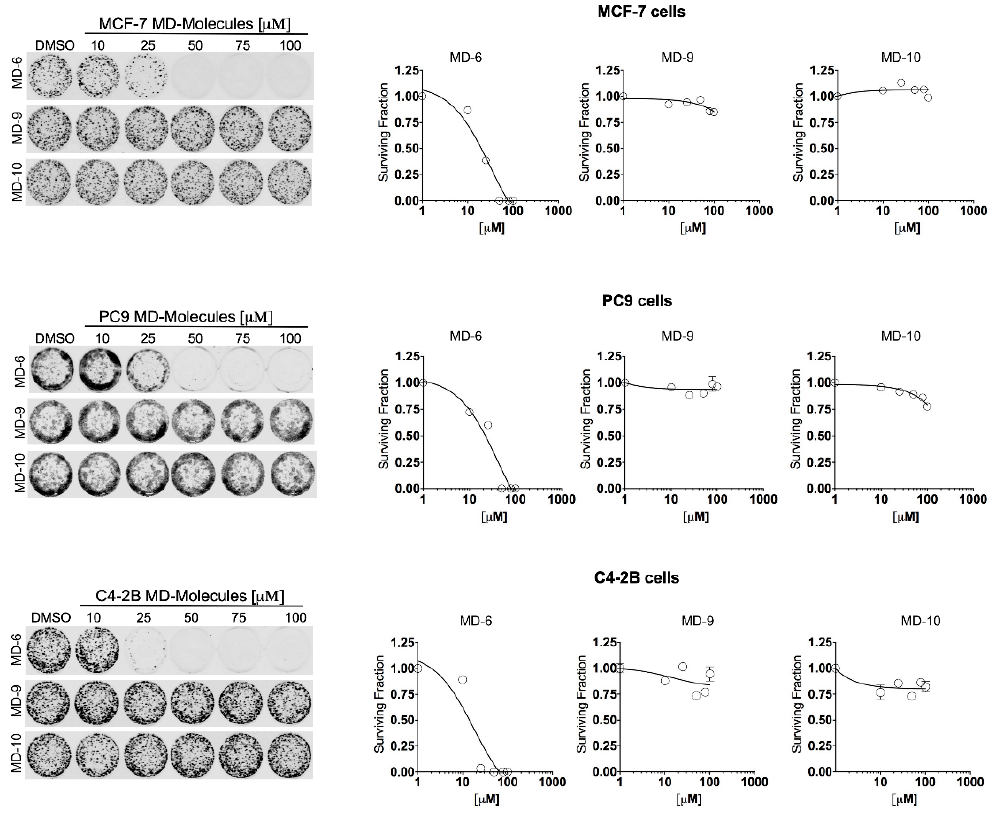
9 of 16 Figure 6. Maytenus disticha extract promotes a mitochondrial membrane potential depolarization. The